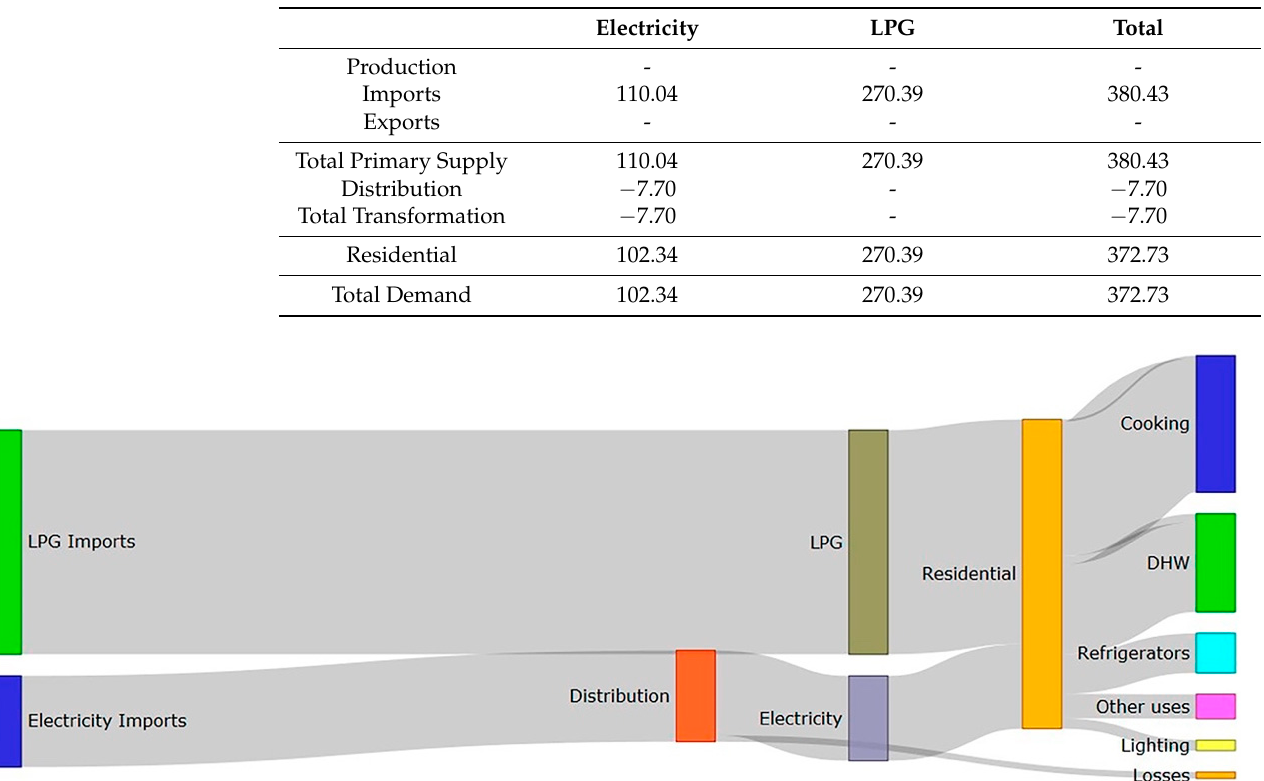
Table 13. Energy balance of the residential sector of Cuenca base year.